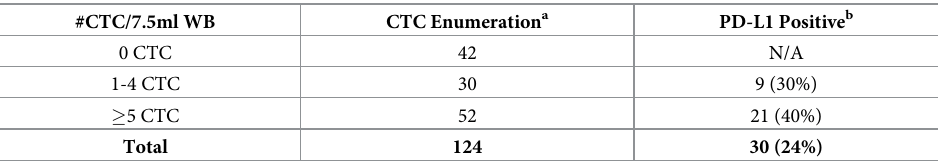
Table 1. CTC PD-L1 expression at timepoint-1.